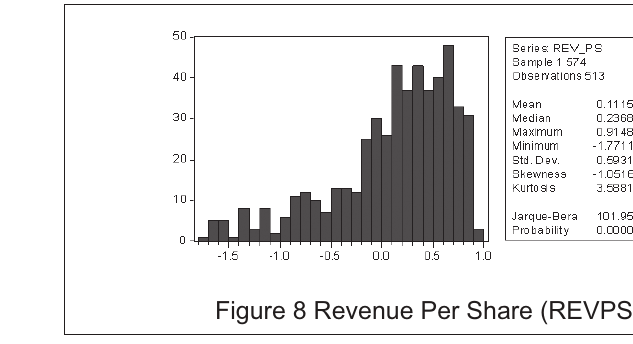
Figure 8 Revenue Per Share